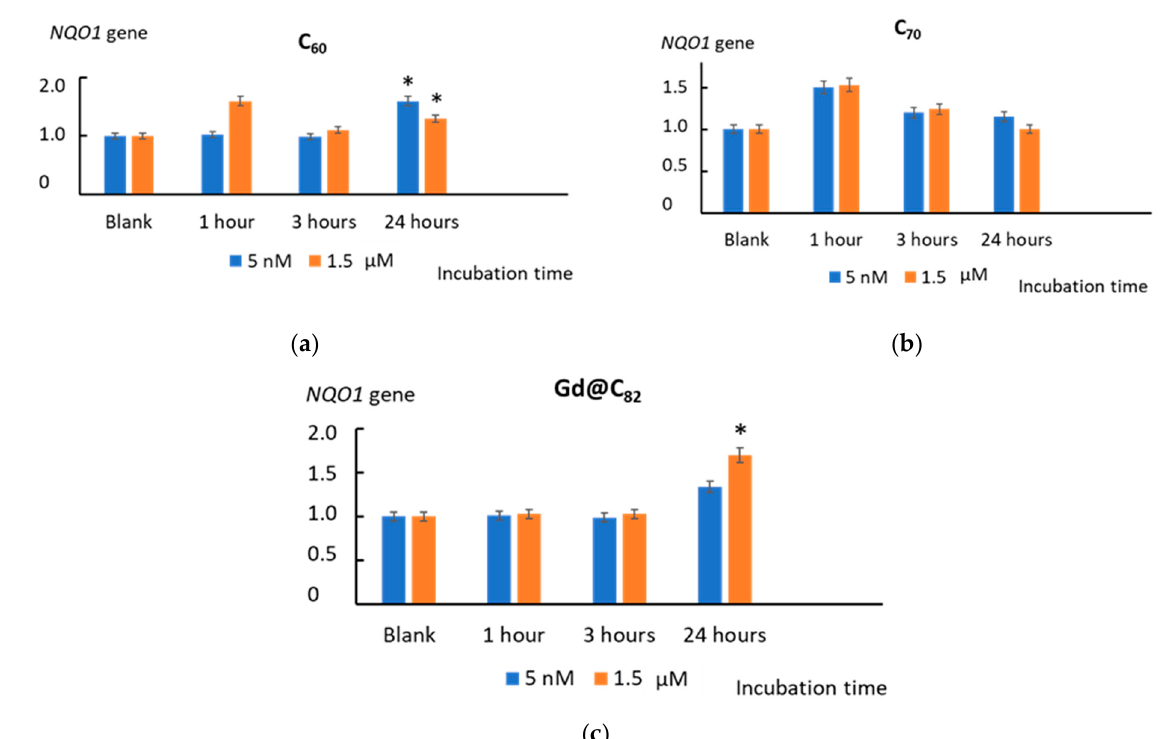
Figure 12. The expression of the NQO1 gene in cells incubated with ( a ) C 60 , ( b ) C 70 , and ( c ) Gd@C 82 at concentrations of 5 nM and 1.5 µM. The NQO1 RNA level is the mean from three replicates related to the NQO1 gene expression in the blank cells. The TBP gene was used as an internal-standard gene. (*) denotes significant differences with the blank cells, p < 0.01, a nonparametric U-test.